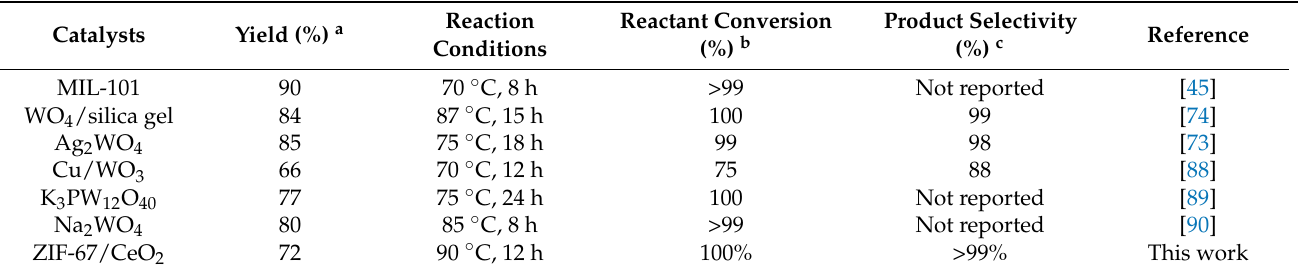
Table 1. Comparison of this work with other reported catalysts producing adipic acid through oxidation of cyclohexene.